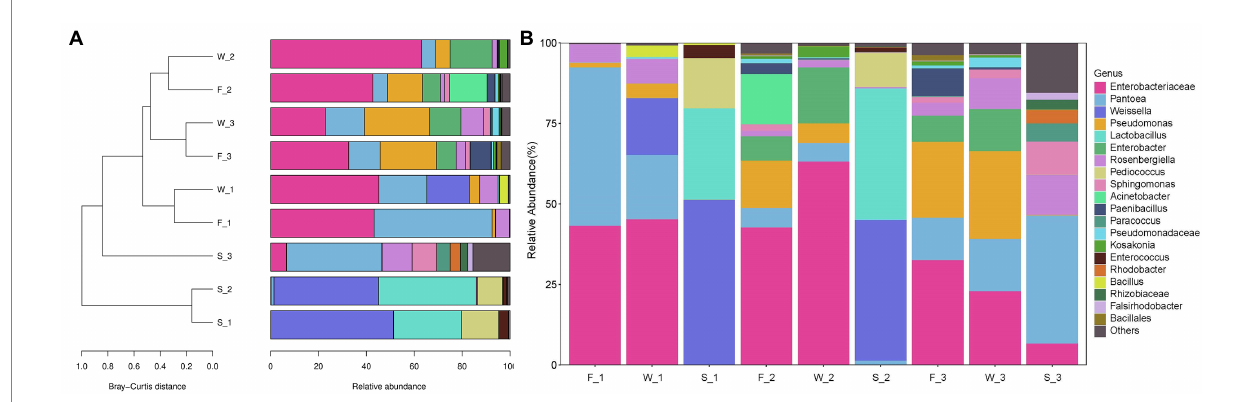
FIGURE 6 Clustering of samples (A) and relative abundance of bacterial communities in alfalfa at genera level (B) . F, fresh alfalfa; W, wilted alfalfa; S, ensiled alfalfa; 1, the first cutting; 2, the second cutting; 3, the third cutting. Bray–Curtis similarity index was calculated using the relative abundance of 20 most predominant bacterial communities at genera level, and hierarchical clustering was calculate using distance matrix using